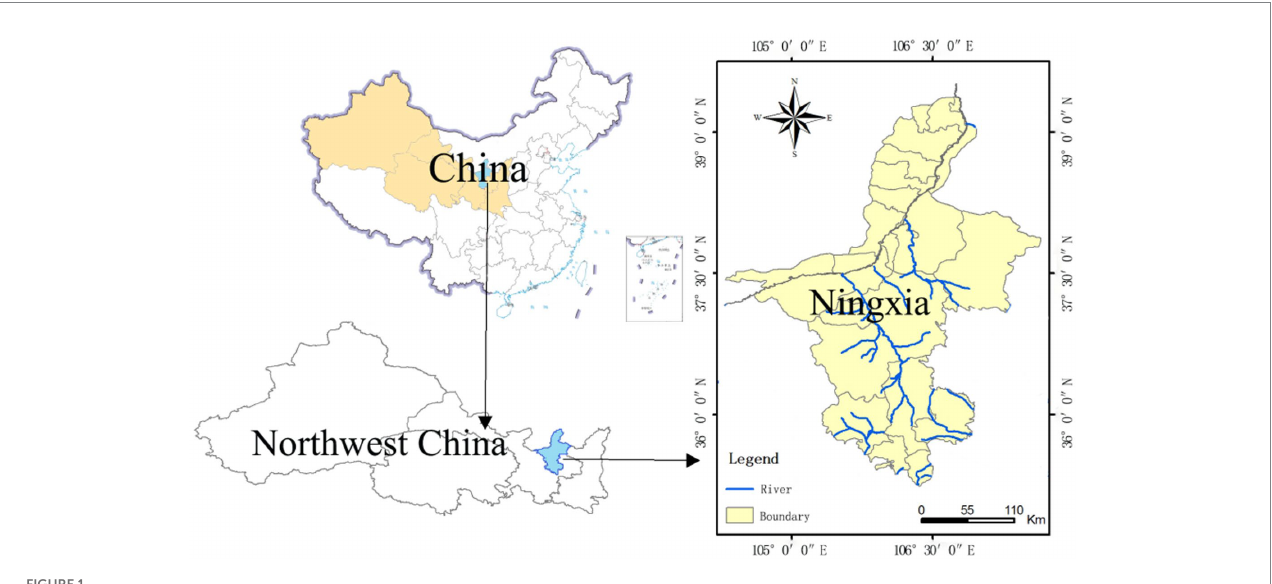
FIGURE 1 Location map of